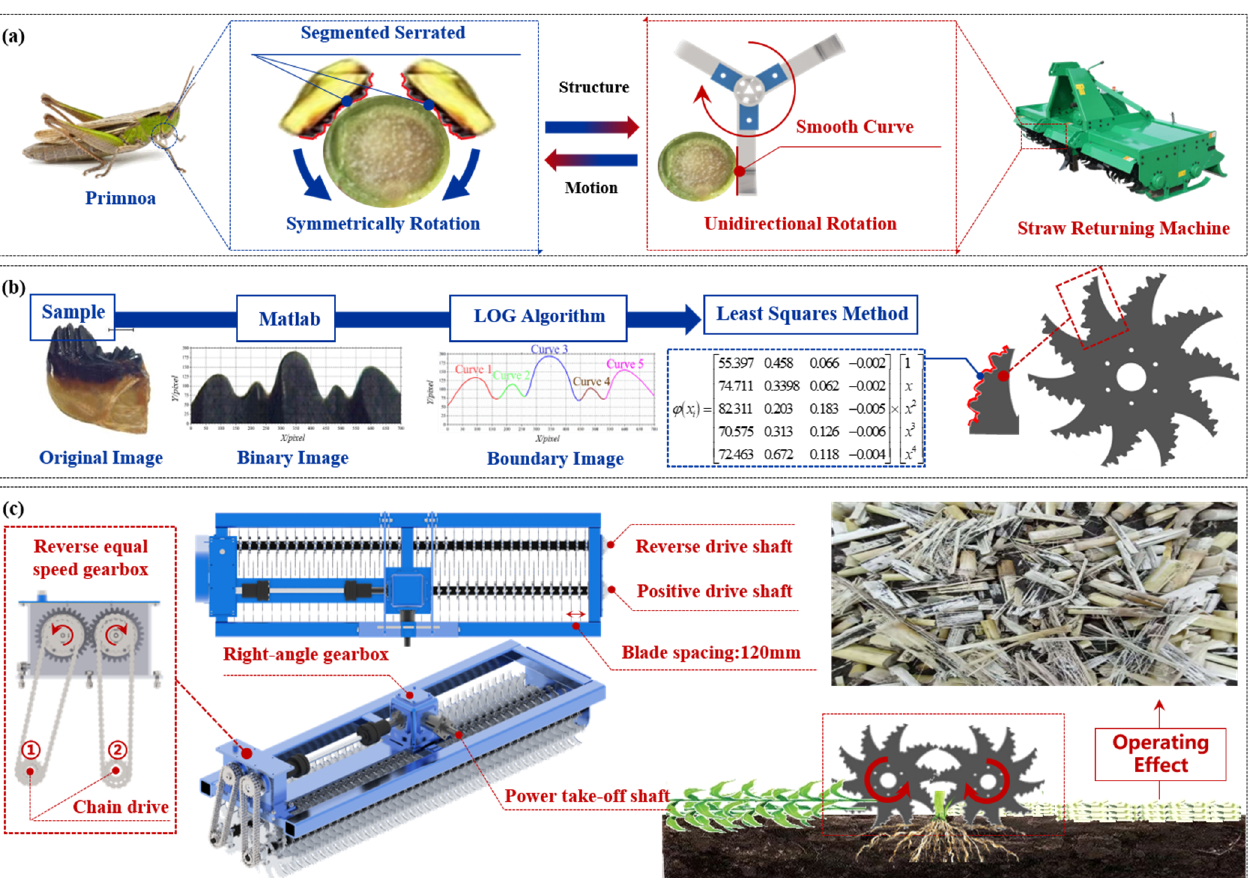
Figure 1. The search for the bionic coupling element of the primnoa mouthpart with efficient cutting ability should start from the main differences between it and the traditional straw returning machine. ( a ) Analysis of the difference between the primnoa mouthpart and the traditional straw returning machine. ( b ) Design process of bionic straw returning blade based on structural coupling elements. ( c ) Operating principle of bionic isokinetic reverse drive system based on motion coupling elements.